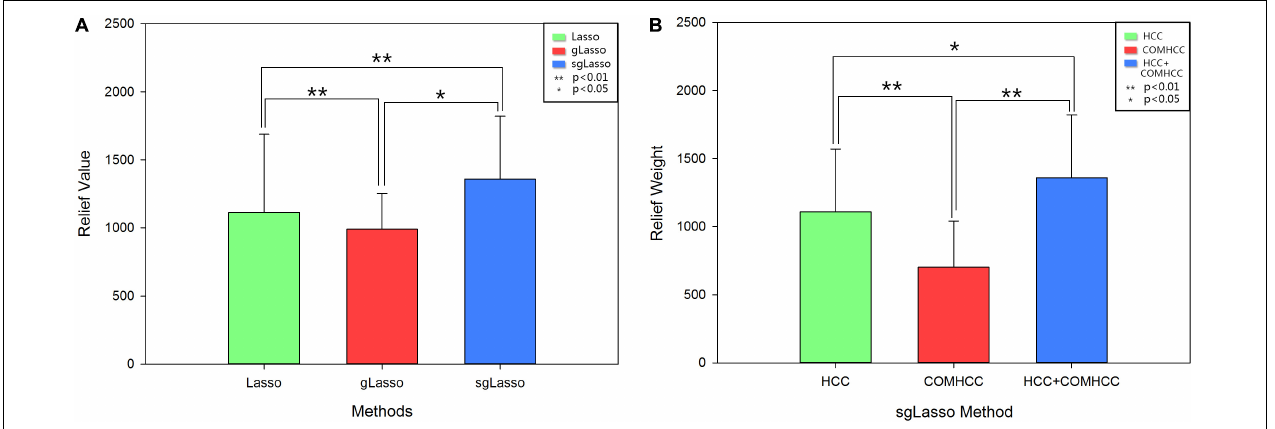
FIGURE 9 | The ReliefF weight of brain regions feature. (A) The ReliefF weight of the corresponding feature of the divergence brain regions obtained by different methods. The Y -axis represents the ReliefF weight, and the X -axis indicates different methods used to construct the hypernetworks. Lasso denotes the ReliefF weight of the corresponding feature of the differential brain regions using the lasso method. gLasso denotes the ReliefF weight of the corresponding feature of the differential brain regions based on the gLasso method. SgLasso denotes the ReliefF weight of the corresponding feature of the differential brain regions calculated by the sgLasso method. (B) The ReliefF weight acquired by different feature extraction ways in the sgLasso method. HCC indicates the ReliefF weight obtained by HCC indicator features. COMHCC indicates the ReliefF weight obtained by COMHCC indicator features. HCC+COMHCC indicates the ReliefF weight by combining HCC indicators feature and COMHCC indicator features. Besides, ∗∗ represents the P values obtained by non-parametric permutation test being less than 0.05, and ∗ represents P values obtained by non-parametric permutation test being less than